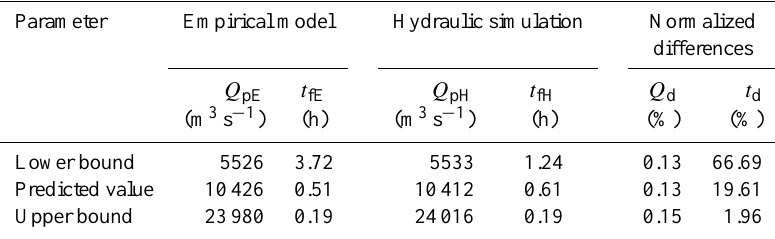
Table 6. Predicted peak outflow and failure time estimated by Froehlich’s empirical models and hydraulic simulation and the associated prediction intervals (upper and lower bounds) for Lake Palcacocha